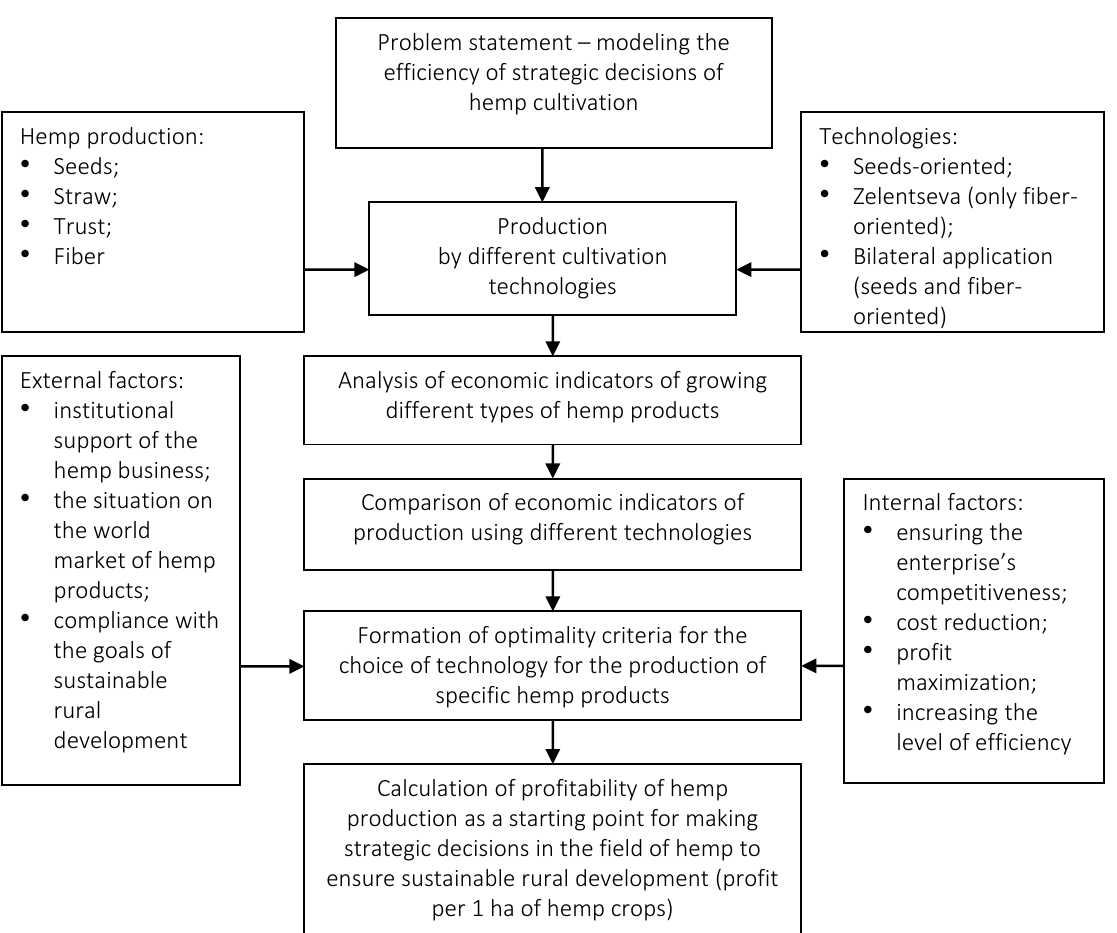
Figure 4. Algorithm for assessing the efficiency of strategic decisions in hemp